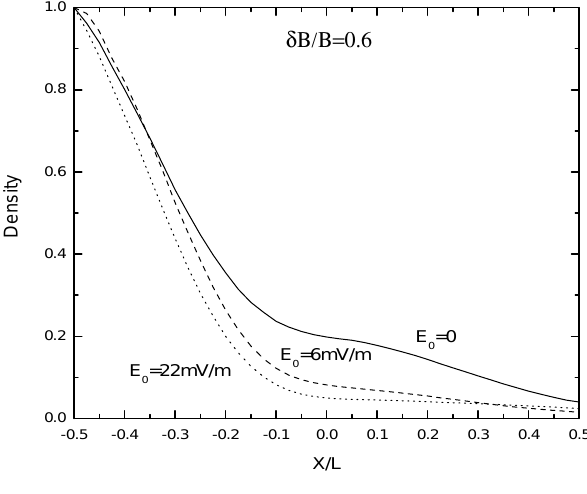
Fig. 11. Oxygen bulk velocity along z for different values of the electric field.